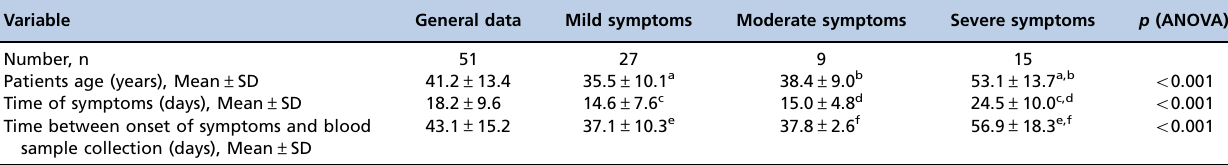
Table 1 - The general characteristics of the patients included in the study split according to symptoms. Variable General